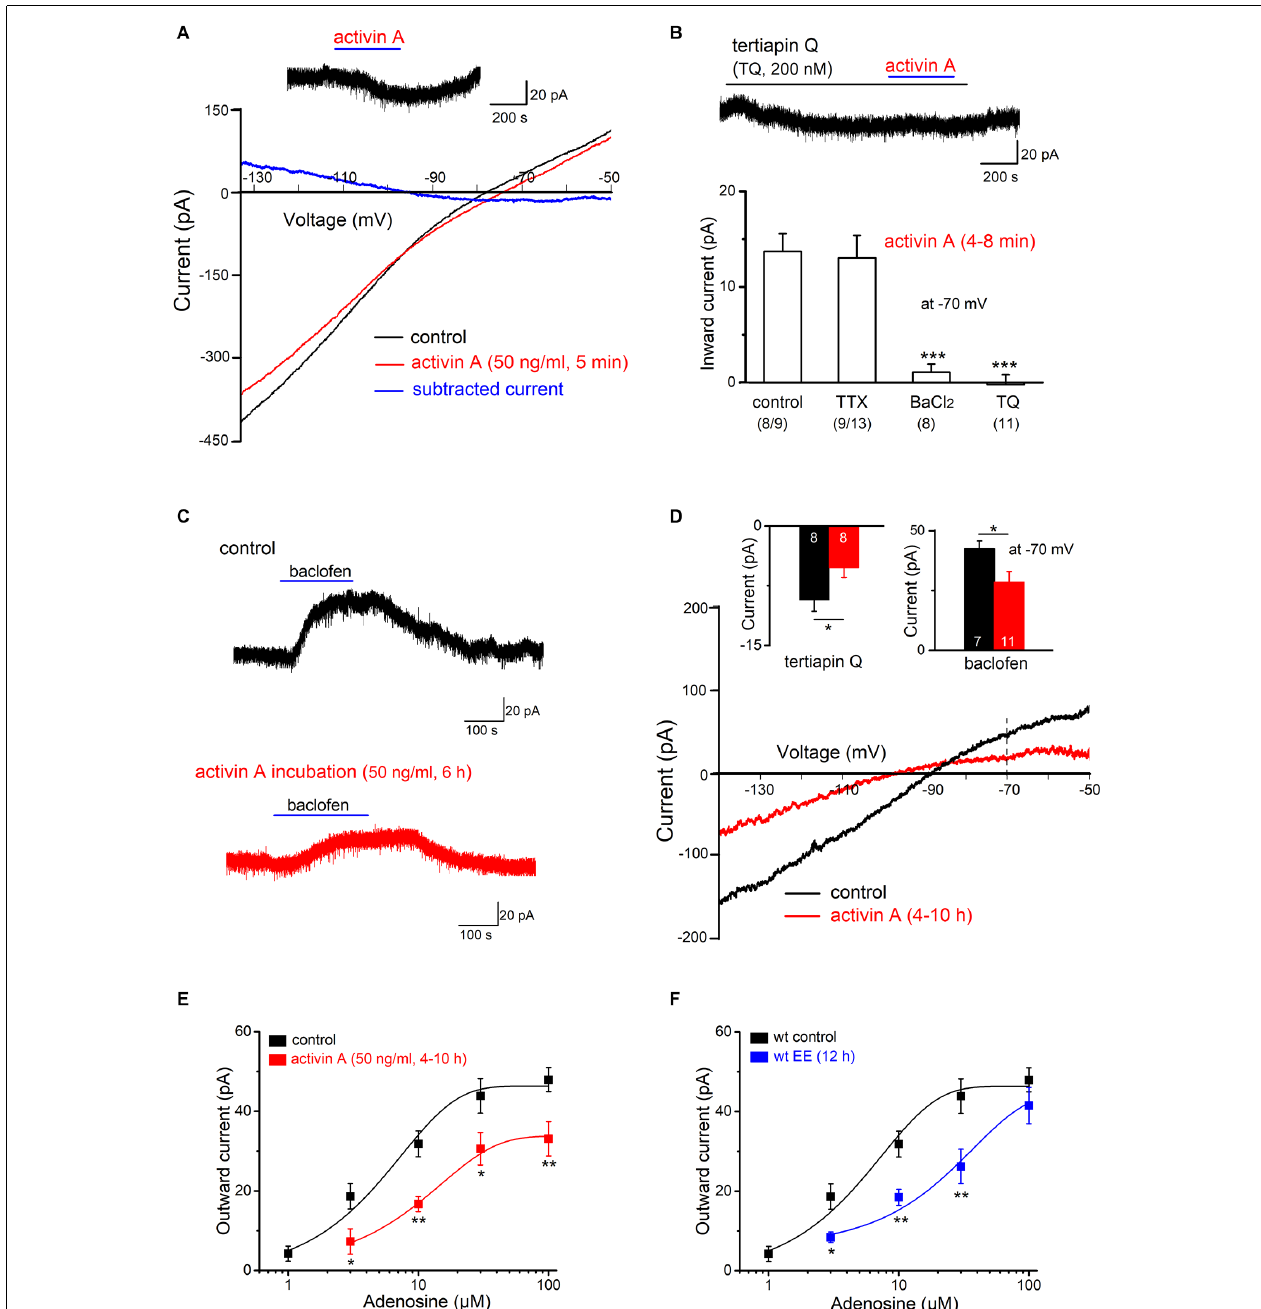
FIGURE 4 | Activin A reduces GIRK current. Whole-cell voltage-clamp recordings were performed from DG granule cells at Vh of -70 mV. (A) Effect of activin A (50 ng/ml for 6 min) on current-voltage (I-V) relationships was determined using a voltage ramp from -50 to -140 mV. Activin-sensitive current (blue trace) was calculated by subtracting I-V curve before (black trace) from that during the maximum effect of activin (red trace). Inset above I-V curves depicts the apparent inward current that was reversibly induced by activin A (V h -70 mV). (B) Summary of activin-induced inward currents at -70 mV. Activin-evoked inward currents were abrogated by BaCl 2 (200 µ M) or specific GIRK channel inhibitor tertiapin Q (TQ, 200 nM), both applied in TTX (1 µ M). Numbers below columns for control and TTX indicate fraction of granule cells displaying an inward current response to activin A. Current trace above the histogram demonstrates that TQ occludes activin suppression of tonic GIRK. (C) Sample traces of baclofen (1 µ M)-induced outward currents (V h -70 mV) in a control slice (black trace) and a slice pre-incubated with activin A (50 ng/ml, 6 h; red trace). (D) I-V curves of baclofen-evoked currents in the absence and presence of activin A pre-treatment. Insets above I-V curves summarize the reduction in baclofen-sensitive outward current (right) and TQ-sensitive inward current (left) in activin A-treated slices (4–10 h). Numbers in columns indicate sample size. (E,F) Dose-response curves for adenosine-induced currents in control slices and in slices pre-treated with activin A (4–10 h, E ) or in slices prepared from EE-exposed mice (12 h; F ). Data points in (E,F) are averages of 5–12 samples. * p < 0.05, ** p < 0.01, *** p < 0.001.